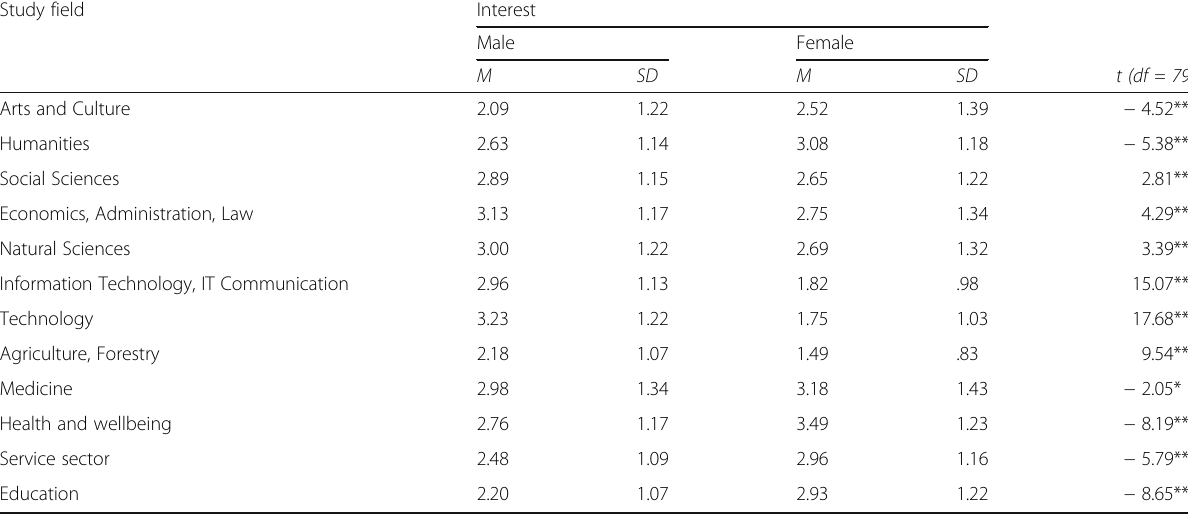
Table 4 Students ’ interest towards study